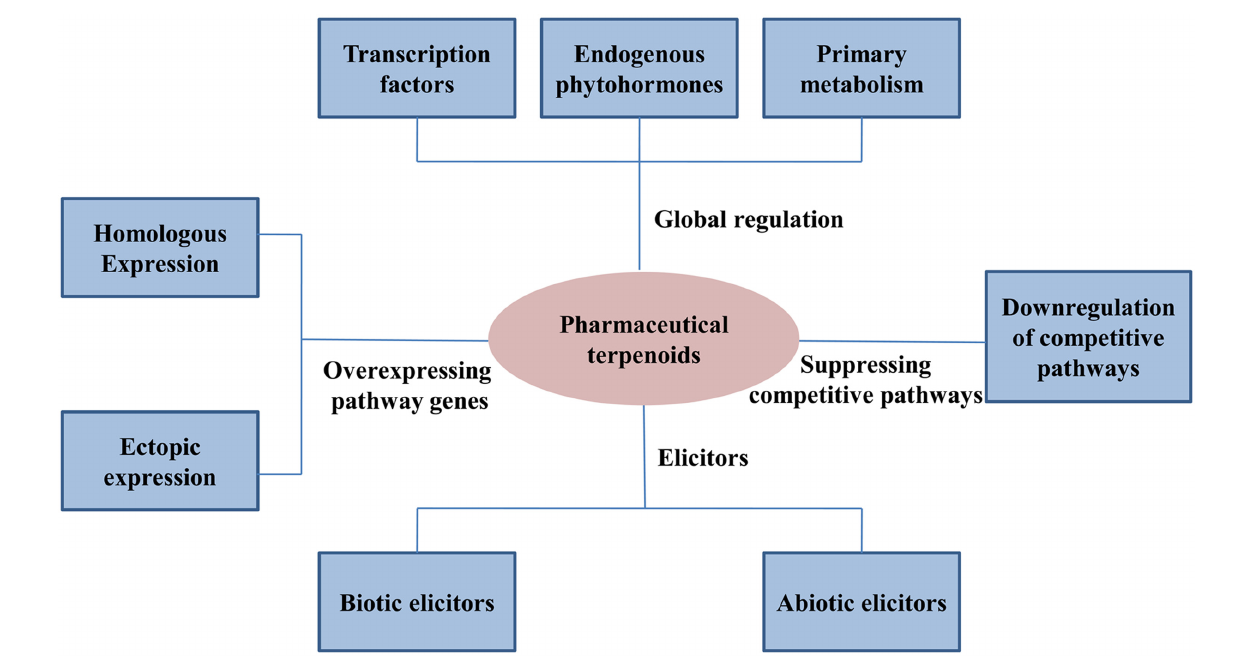
FIGURE 2 | Plant metabolic engineering strategies to regulate pharmaceutical